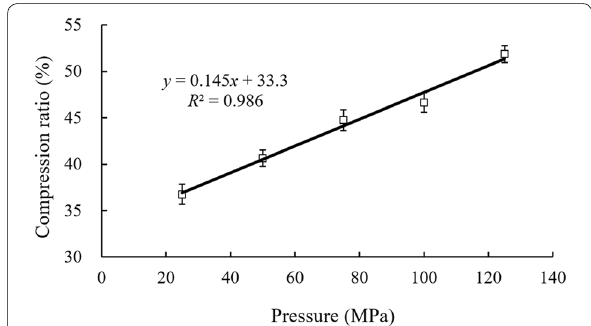
Fig. 5 Relationship between compression ratios and pressure levels after treatment